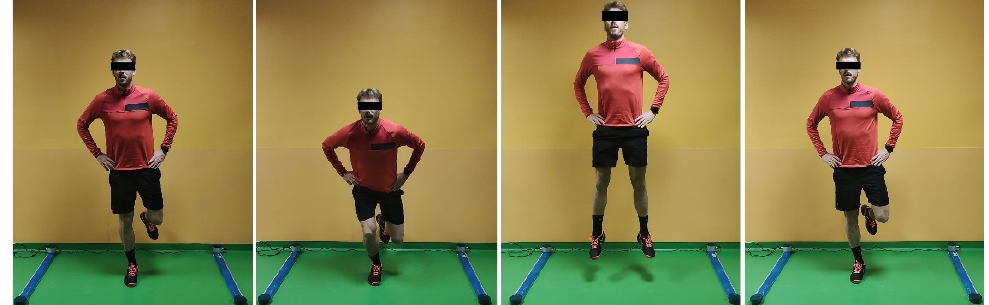
Figure 3. Monopodalic countermovement jump.